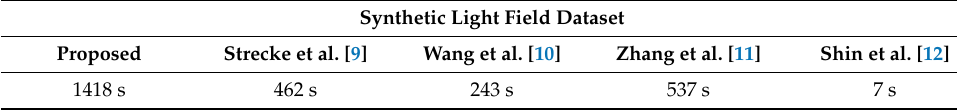
Table 7. Average runtime for synthetic data.